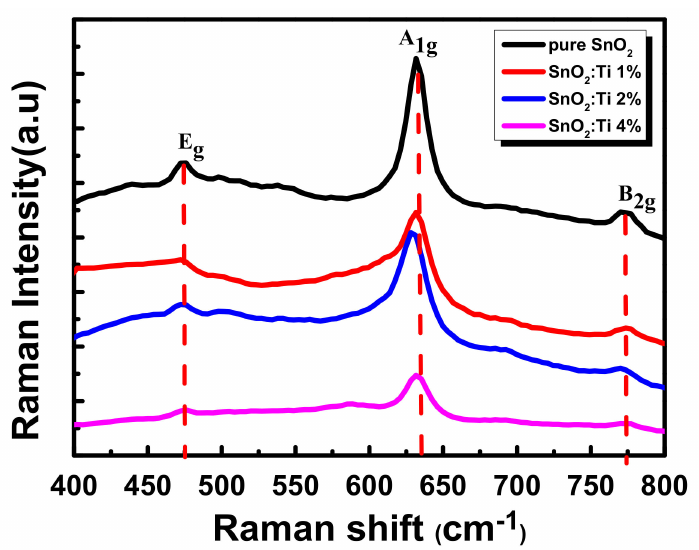
Figure 6. Raman spectra of Ti–SnO 2 NPs.